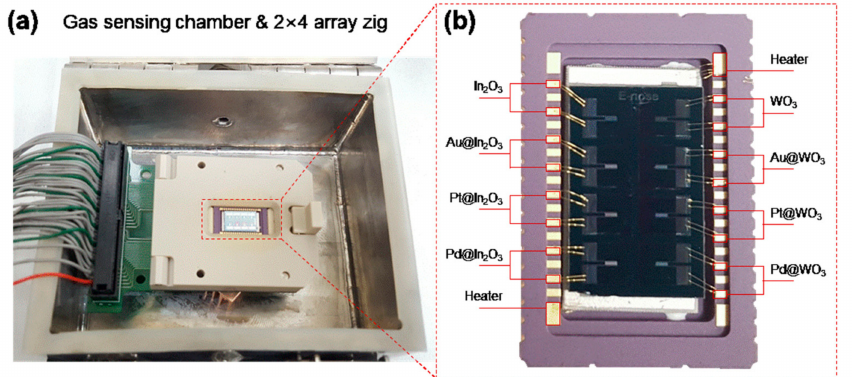
Figure 3. ( a ) Optical image of the gas sensing chamber and ( b ) 2 × 4 sensor array mounted on the micro-heater and the chip